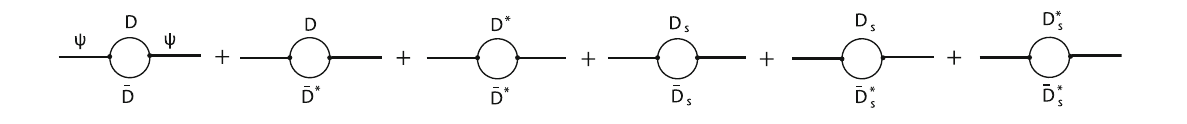
Fig. 4 Contribution to the ψ selfenergy for the vector ψ propagator dressed with a meson–meson loop with cc